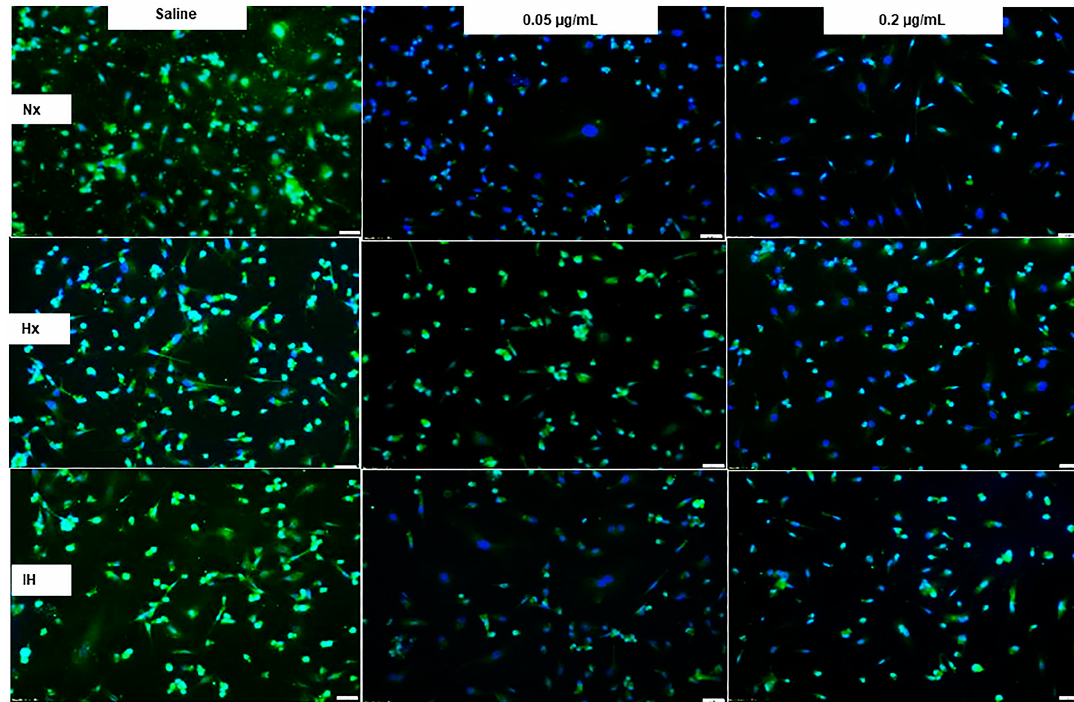
Figure 9. Representative images of the effect of bumetanide on aquaporin (AQP)-4 immunoreactivity (red) counterstained with DAPI (blue) in cultured human microvascular retinal endothelial cells (HMRECs) exposed to normoxia (Nx), hyperoxia (Hx, 50% O 2 ), or intermittent hypoxia (IH) for 72 h. Images were captured at 20× magnification (scale bar is 50 µm). Quantitative analysis of AQP-4 immunoreactivity is presented in Table 1.